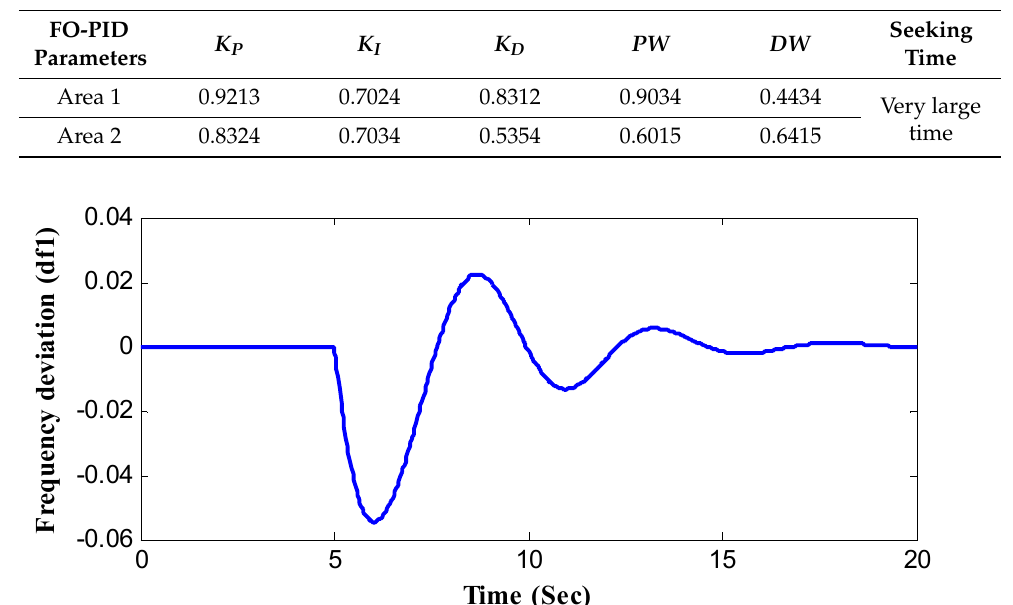
Figure 6. Frequency deviation ( ∆𝑓 (cid:2869) ) using conventional 2DOF-OPID controller